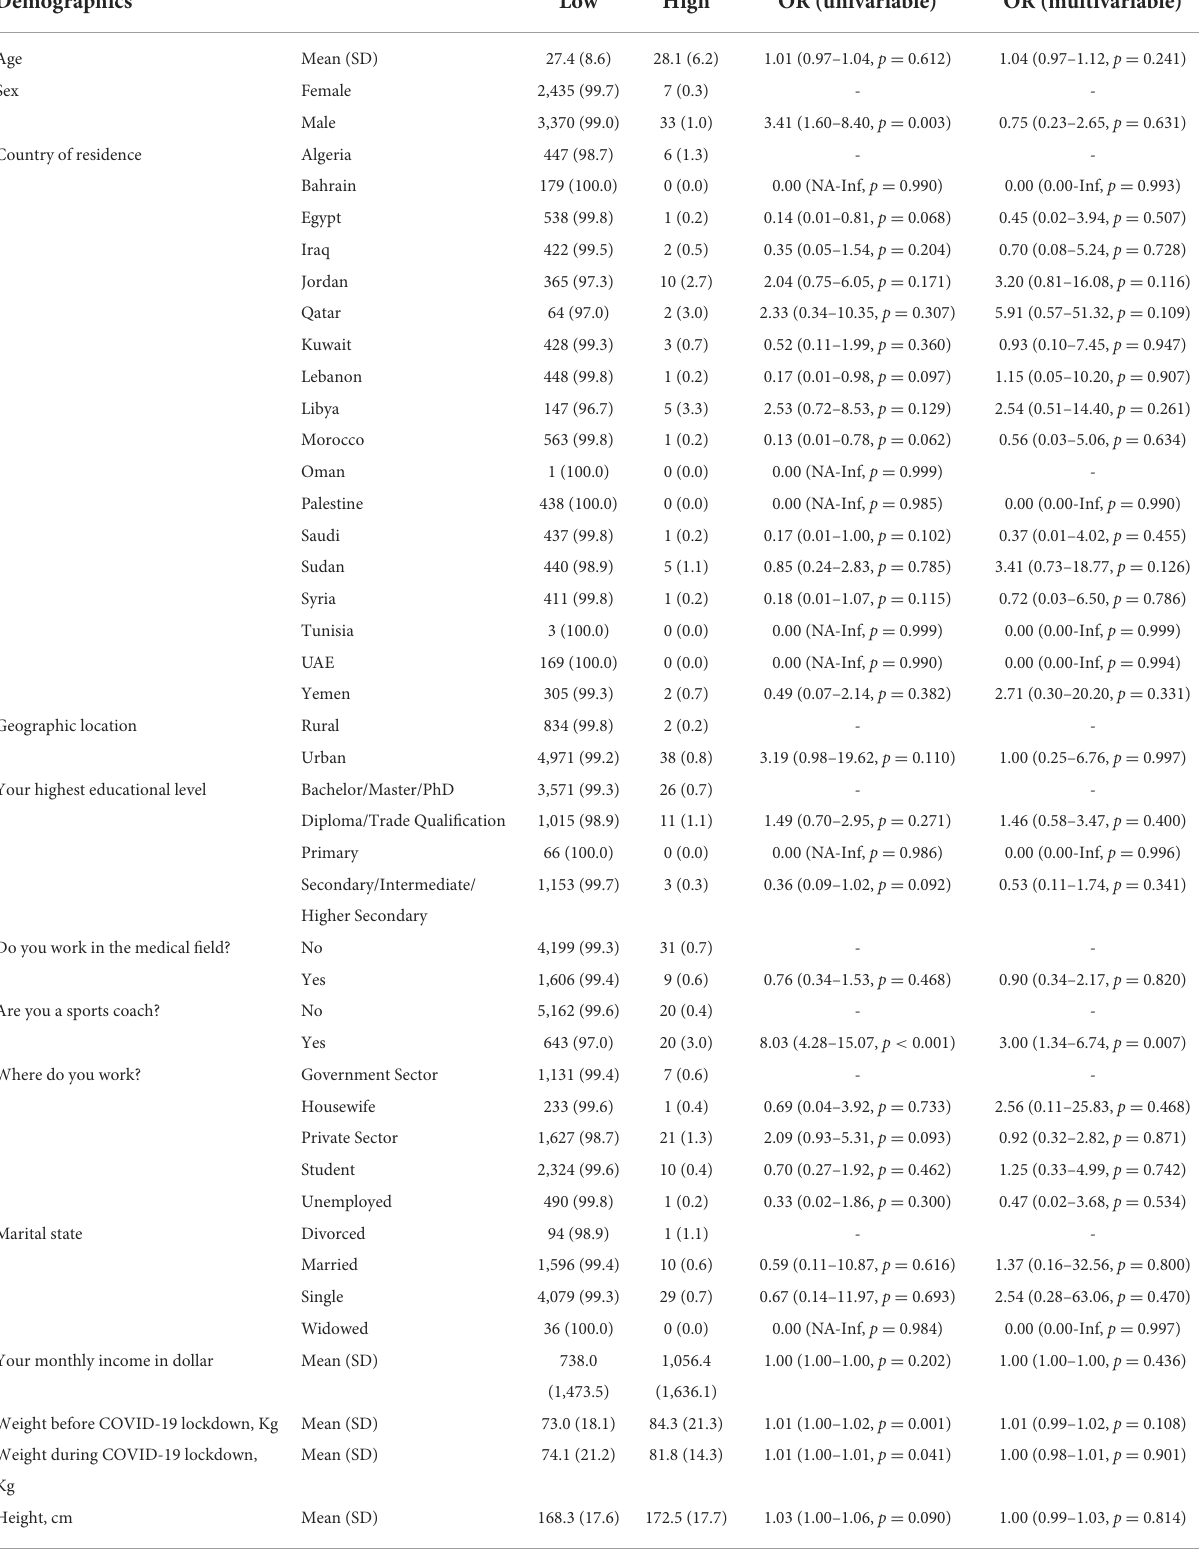
TABLE 9 Logistic regression models for the association between demographics and high level of